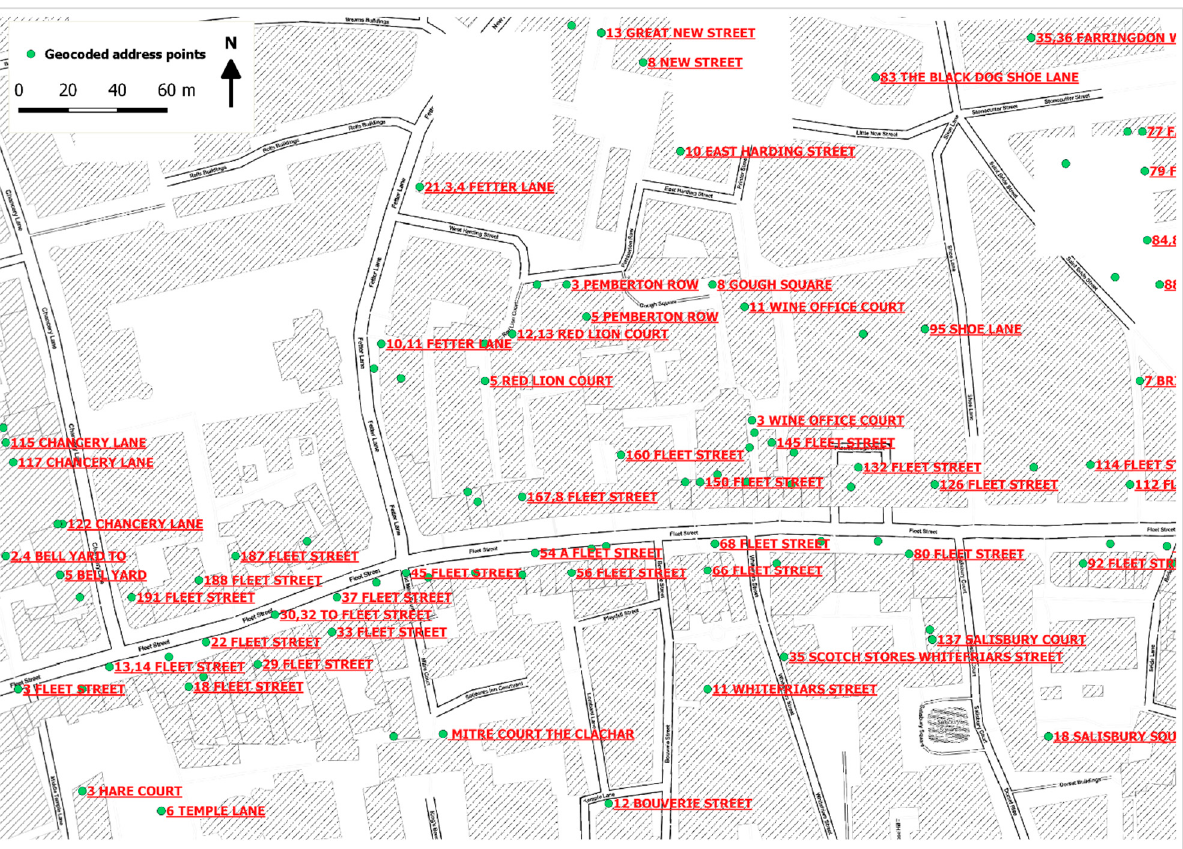
Figure 4. Examples of geo-referenced census addresses (green circles) and (red) labels along Fleet Street in the City of London. (Base map source: style using Stamen Black and White by Stamen Design, data © OpenStreetMap) .